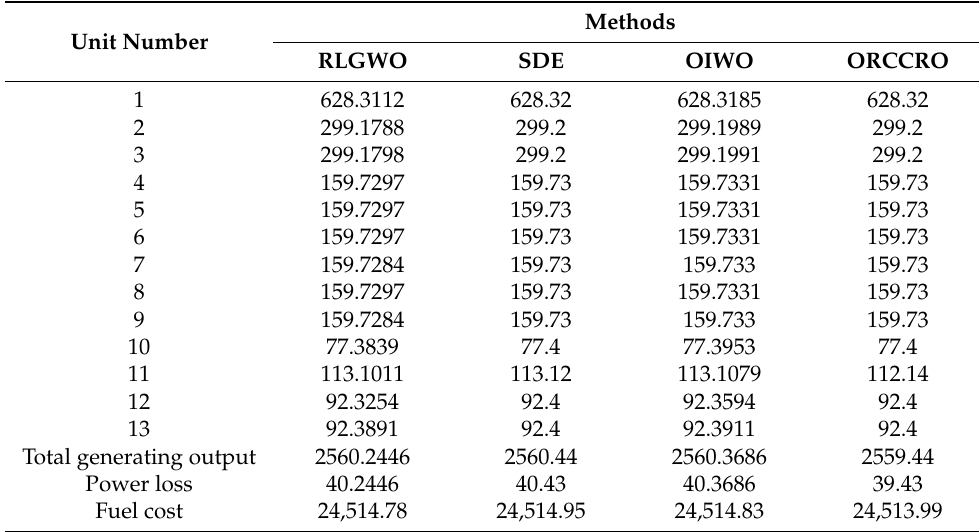
Table 1. Best simulation results of the 13-unit system with loss ( P D = 2520 MW). Unit